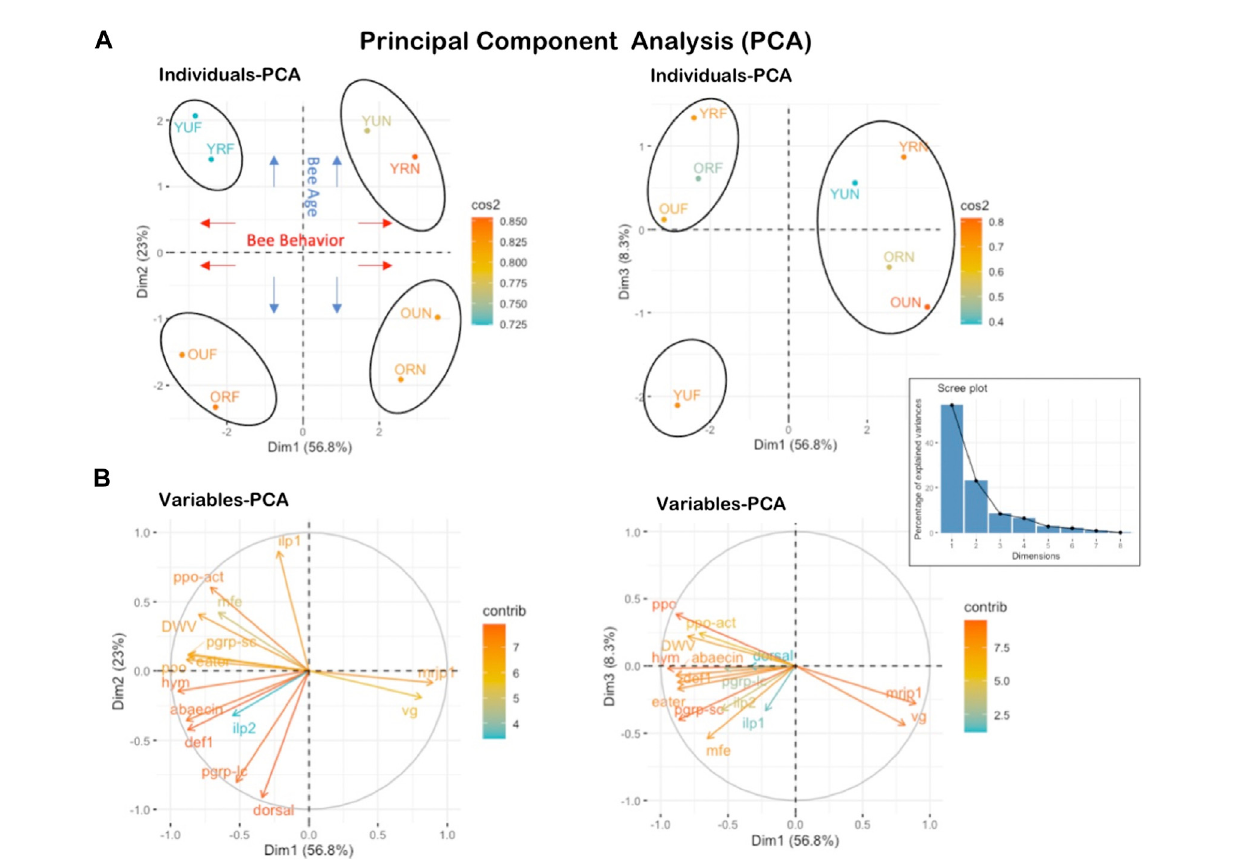
FIGURE 7 Principal Component Analysis PCA conducted on all studied genes and treatment categories. (A) shows the projection of the eight individual treatments (YUF, YRF, OUF, ORF, YUN, YRN, OUN, ORN) on PC axes 1 and 2 as well as 1 and 3.56.8% of the variables are expressed on axis 1% and 23% on axis 2. (B) It shows the projection of variables (gene expression) on the three fi rst axes of the PCA. Both mrjp1 and vg genes exhibit opposite expression compared to all other studied